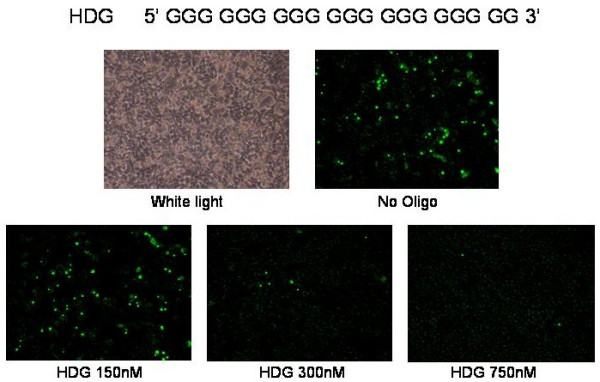
HDG was co-transfected at the indicated concentrations with p72Q and the cells were photographed 48 hours later in dark field.